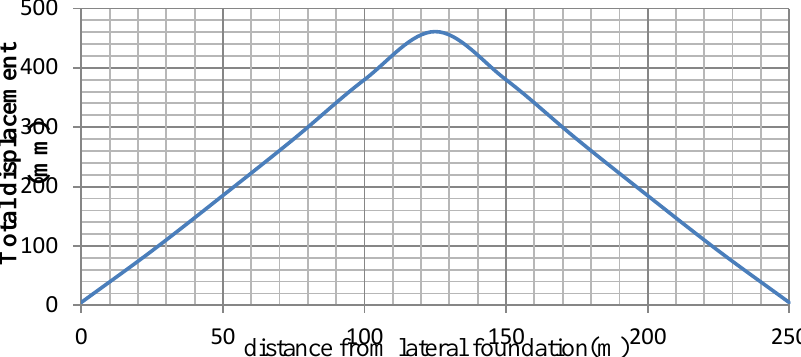
Fig. 6. Total displacement of the dam’s crest (mm) versus the distance from the lateral base (m).